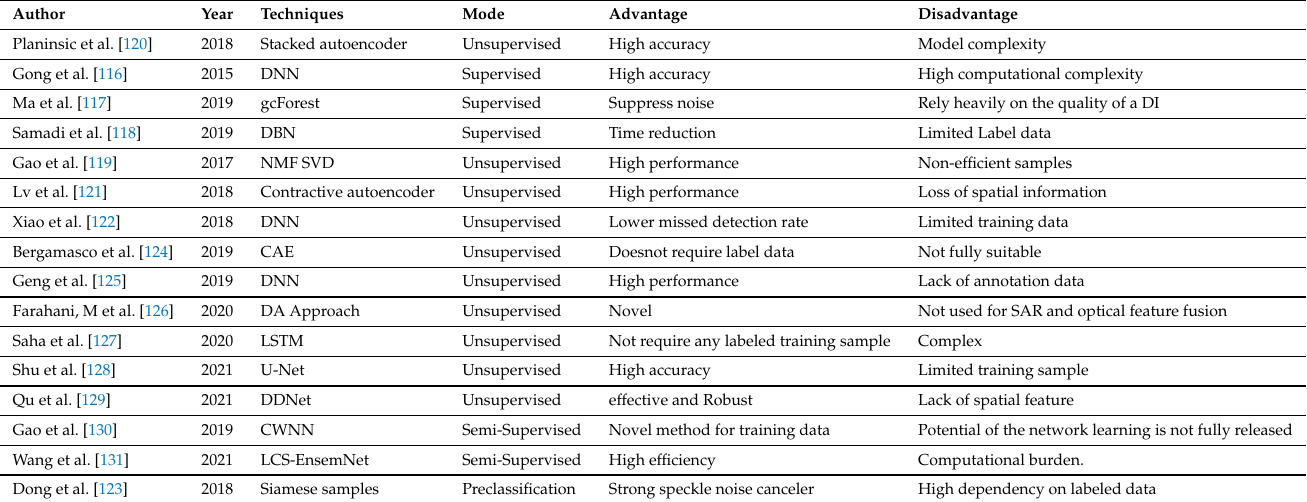
Table 9. Summary of the literature work of change detection techniques based on a SAR image